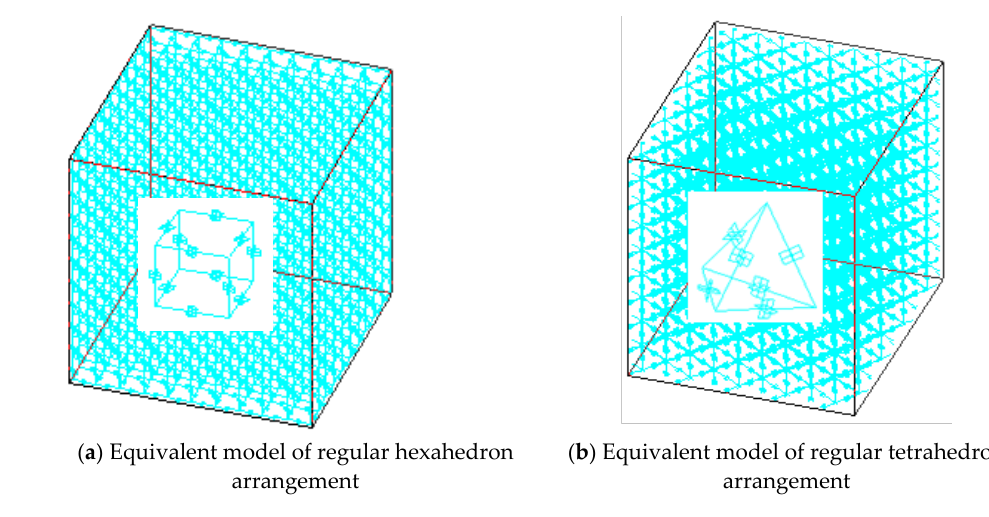
Figure 9. Space equivalent 3D-RBSN model.